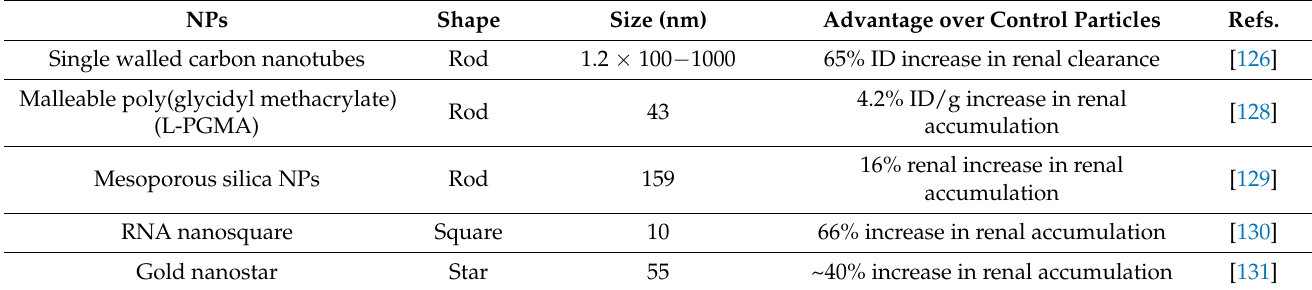
Table 3. The influence of the NPs with various shapes on their renal clearance and